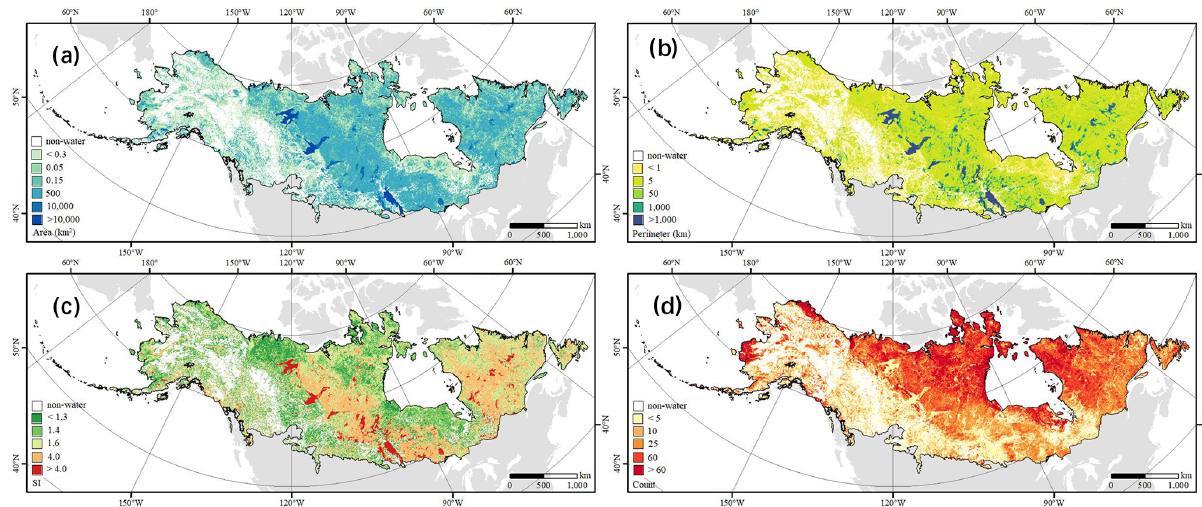
Figure 7. The aggregated distribution of area (a) , perimeter (b) , and SI (c) and the number (d) of the identified water bodies in the study area. The values at each 5km × 5km pixel in the grid were calculated by selecting the intersecting water bodies and then either counting or calculating the mean of the targeted parameter (e.g., area, SI, and perimeter) of these selected water